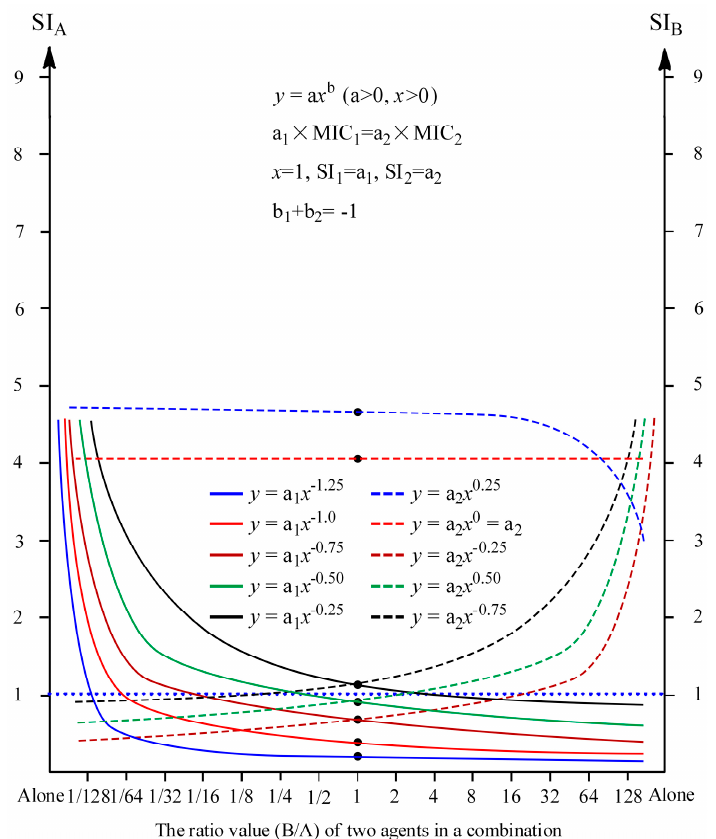
Figure 1. Diagrams of typical curve outlines showing the representative correlations between the SI (y) of one agent in drug combinations and the ratio (x) of two agents. Two functions y = a 1 x b1 and y = a 2 x b2 , respectively passing the dots (1, a 1 ) and (1, a 2 ) when x = 1, were established for two agents A and B in a drug combination, and the longitudinal coordinates SI A and SI B were respectively the SIs of two agents A and B.